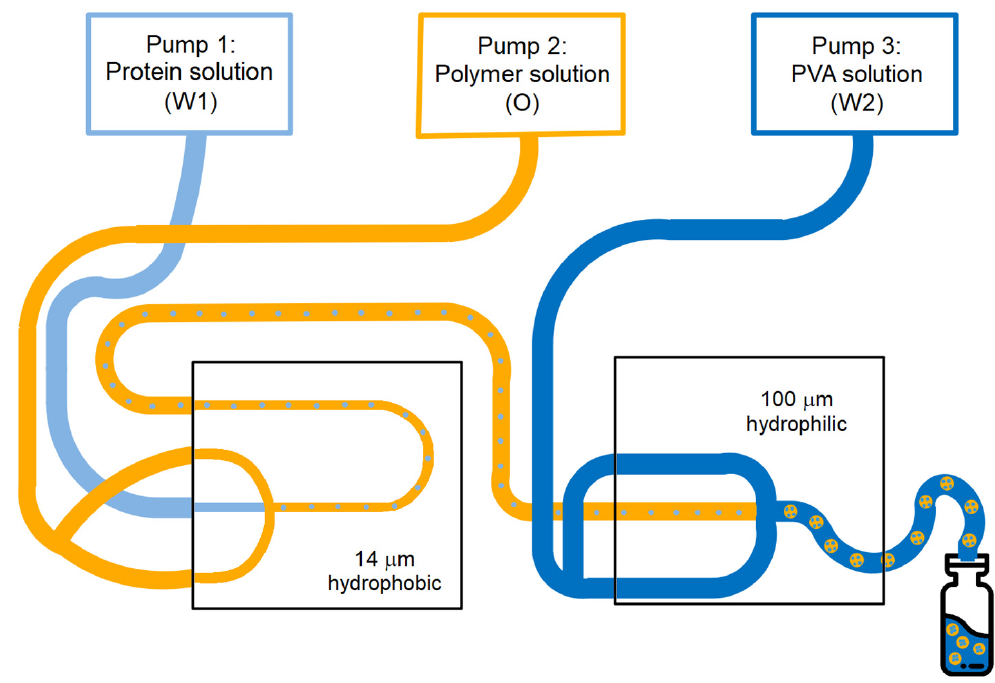
Figure 1. Schematic representation of the microfluidic setup used for the production of core–shell microspheres.